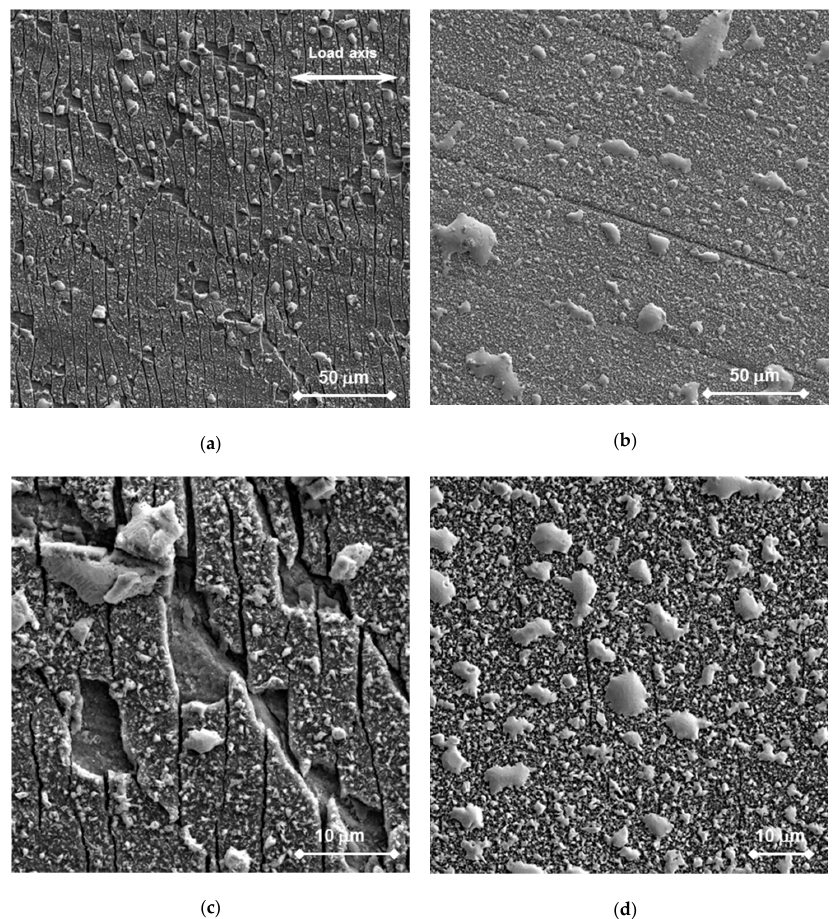
Figure 8. Tapered specimen T36 (R0) in Pb without chemical cleaning: the ground surface ( a ) in the minimum cross section showing a number of cracks in the oxide; ( b ) 5.8 mm from the minimum cross section showing visible machining grooves under the oxide layer; ( c ) detail of ( a ); ( d ) the last (furthest) cracks in the oxide.